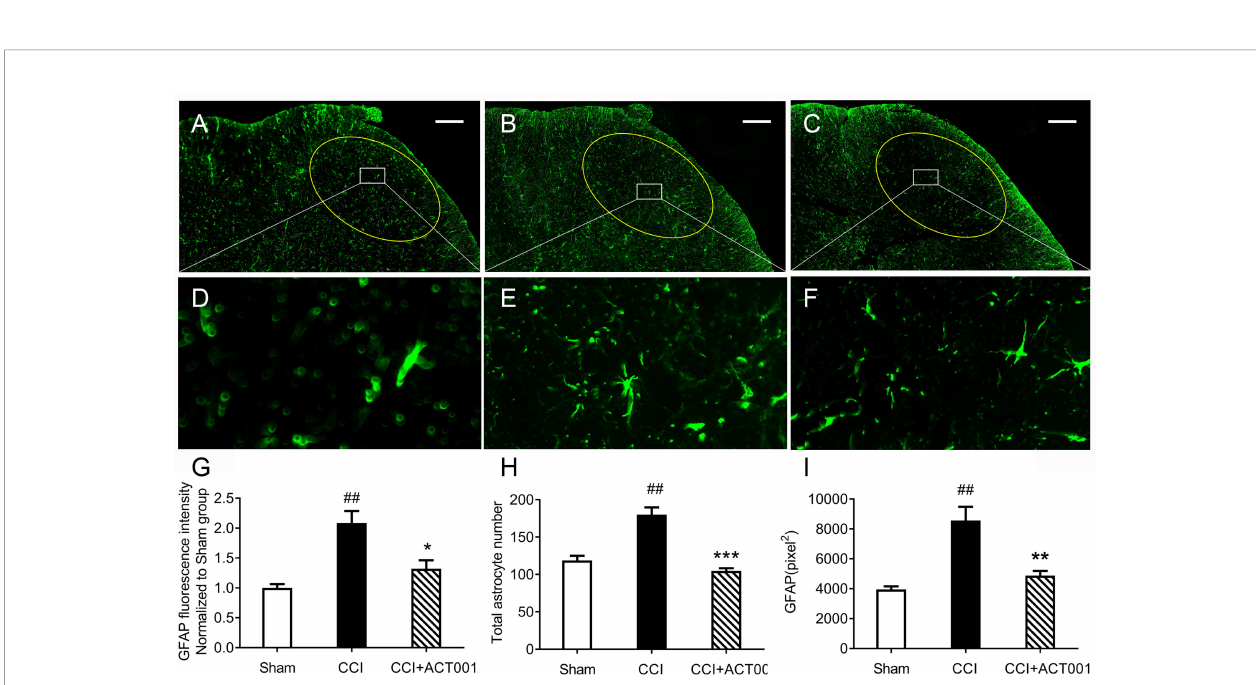
FIGURE 8 | ACT001 inhibits astrocyte activation markers expression induced by CCI. The lumbar spinal cords (L4-L6) were collected following the fi nal behavioral testing shown in Figure 6 . These tissues were stained for astrocyte activation markers. (A-C) Representative immuno fl uorescence GFAP images for the sham group (A) , CCI group (B), and CCI + ACT001 group (C) . (D-F) Representative images for sham group (D) , CCI group (E), and CCI + ACT001 group (F) with high magni fi cation (×60). (G-I) The quanti fi cation of GFAP expression was shown as normalized fl uorescence intensity (G) , number (H) and size of (I) astrocyte. Scale bar = 200 m m. All the data represented mean ± SEM. ## P< 0.01 versus the sham group; *P< 0.05, **P< 0.01, *** P< 0.001 versus the CCI group.